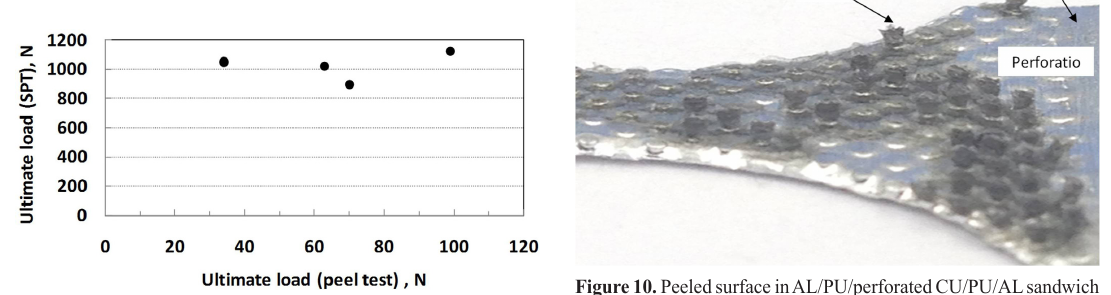
Figure 8. The relation between SPT ultimate load and the peeling load.